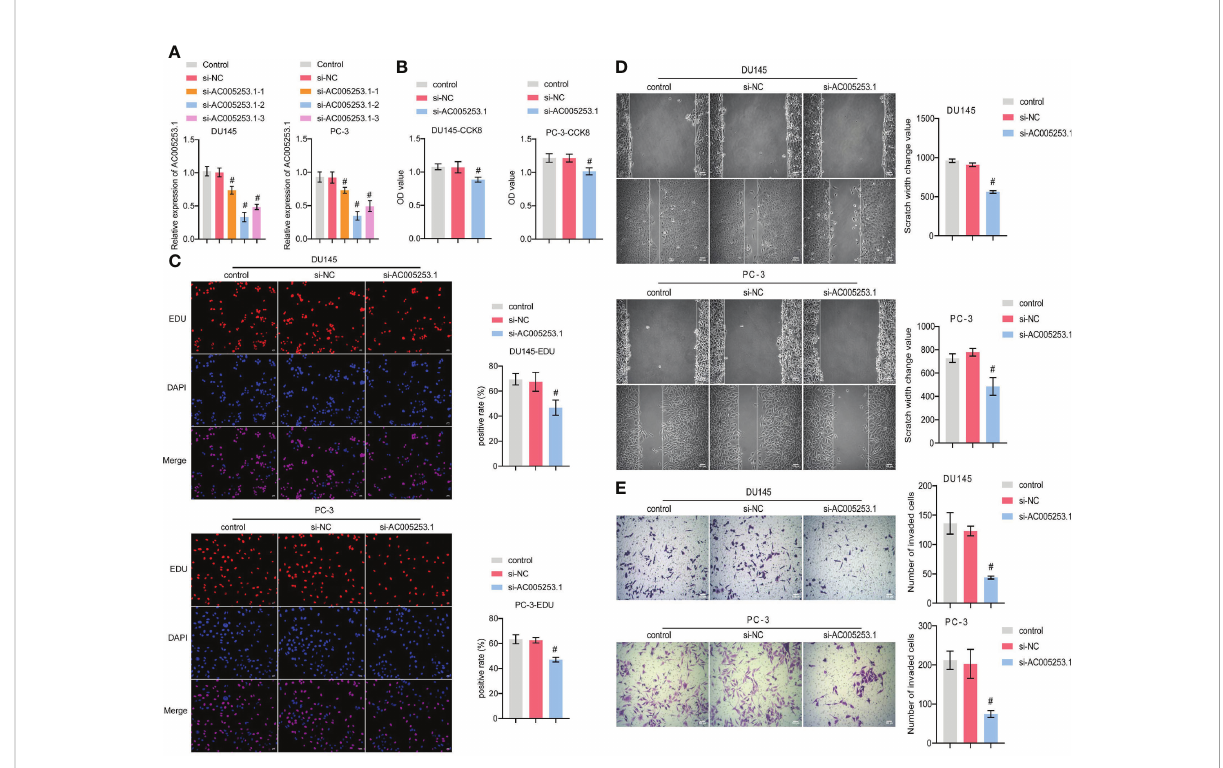
FIGURE 8 Silencing of AC005253.1 affected PCa cell proliferation, migration, and invasion. (A) RT-qPCR detection of AC005253.1 expression in PC-3 and DU145 cells. (B) CCK-8 assay was used to measure the cell viability in PC-3 and DU145 cells. (C) EDU assay results showed the effect of si- AC005253.1 on cell proliferation. (D) Wound healing assay was performed to detect the migration in PC-3 and DU145 cells. (E) Transwell assay was used to detect the invasion of PC-3 and DU145 cells. #p < 0.05, vs. si-NC group. PCa, prostate cancer; CCK-8, Cell Counting